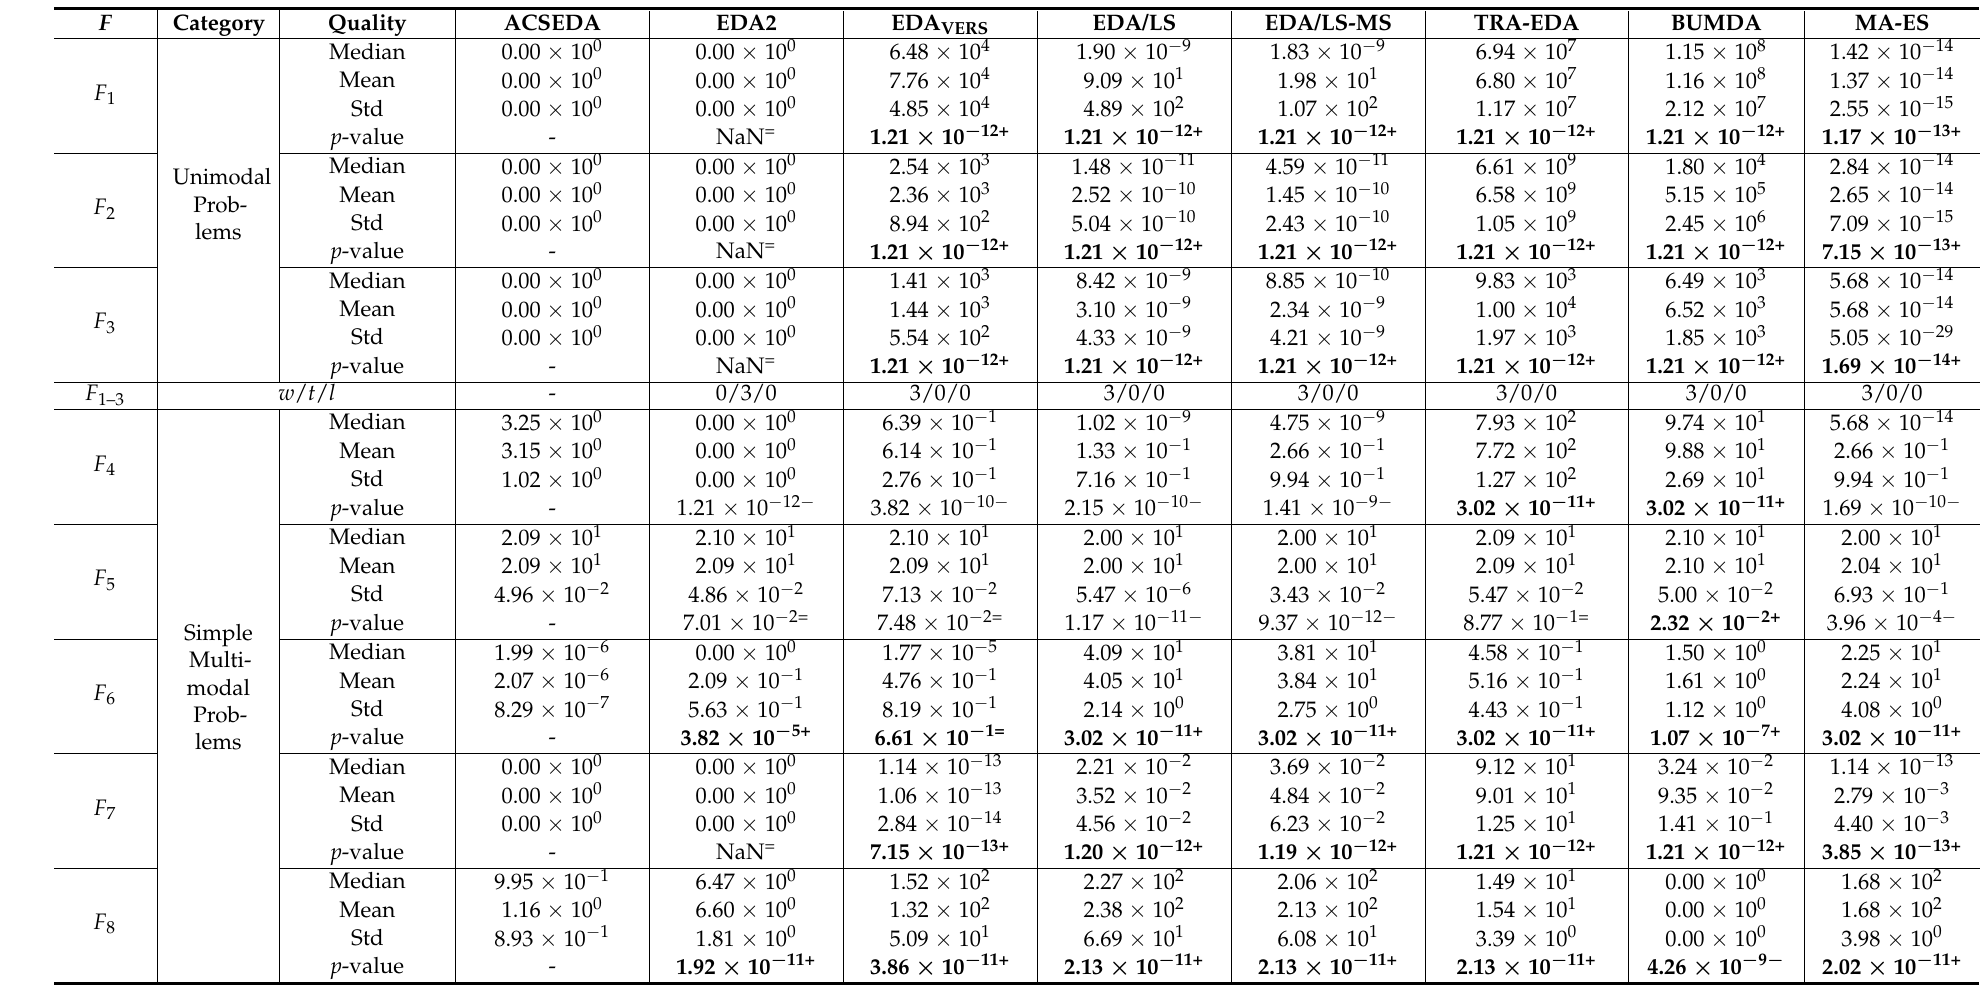
Table 2. Comparison between ACSEDA and the compared state-of-the-art EDA variants on the 30- D CEC2014 benchmark problems. The bold results indicate that ACSEDA is significantly better than the compared